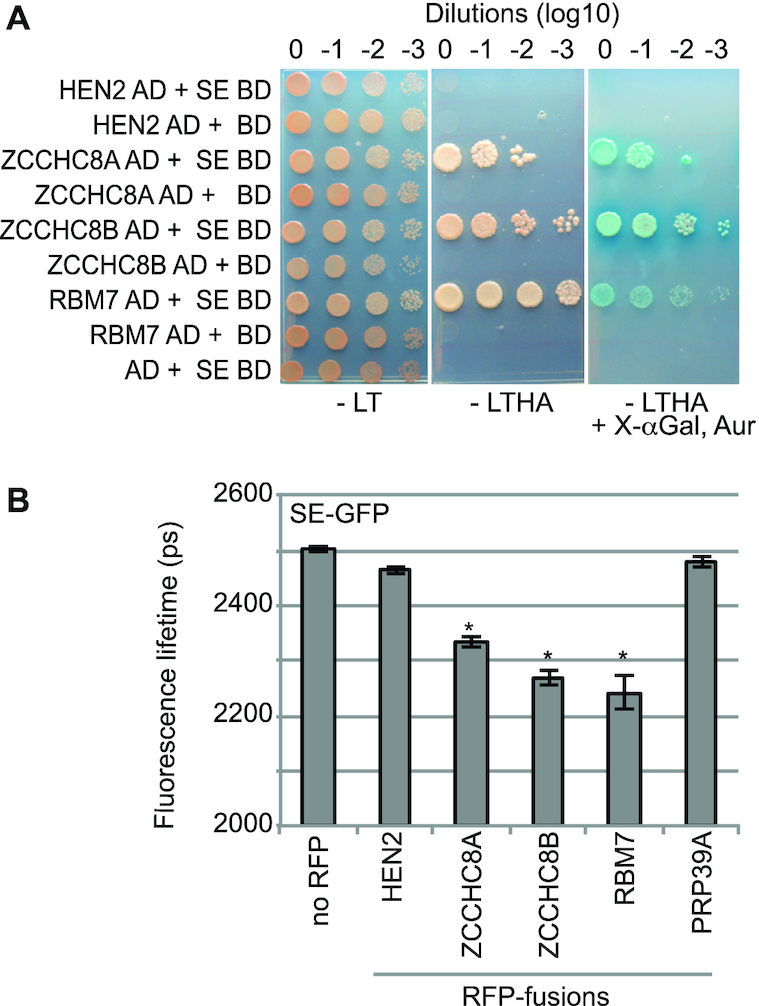
SERRATE interacts with the RBM7 and ZCCHC8 subunits of the NEXT complex. (A) Yeast two-hybrid assays. SE was fused to the Gal4 DNA BD. HEN2, ZCCHC8A, ZCCHC8B and RBM7 were fused to the Gal4 AD. Yeast co-expressing the indicated proteins and SE-BD or harbouring the empty pGBDKT7 vector were selected on medium lacking the amino acids leucine (L) and tryptophan (T). Interaction was tested on medium lacking also histidine (H) and adenine (A), as well as on medium complemented with aureobasidin (Aur) and the galactosidase substrate X-αGal. (B) FRET-FLIM analyses of Arabidopsis protoplasts expressing GFP fused to SERRATE as fluorescent donor protein. HEN2, ZCCHC8A, ZCCHC8B, RBM7 and PRP39A (as negative control) fused to RFP were used as acceptor proteins. The bar graph presents the fluorescence lifetime of SE-GFP in picoseconds (ps). Error bars indicate the standard error of the mean, n > 10. The asterisks indicate significant differences (P < 0.001, Mann–Whitney–Wilcoxon test) between the control samples co-expressing SE-GFP and PRP39A-RFP, and the samples co-expressing SE-GFP and the indicated RFP fusion proteins.